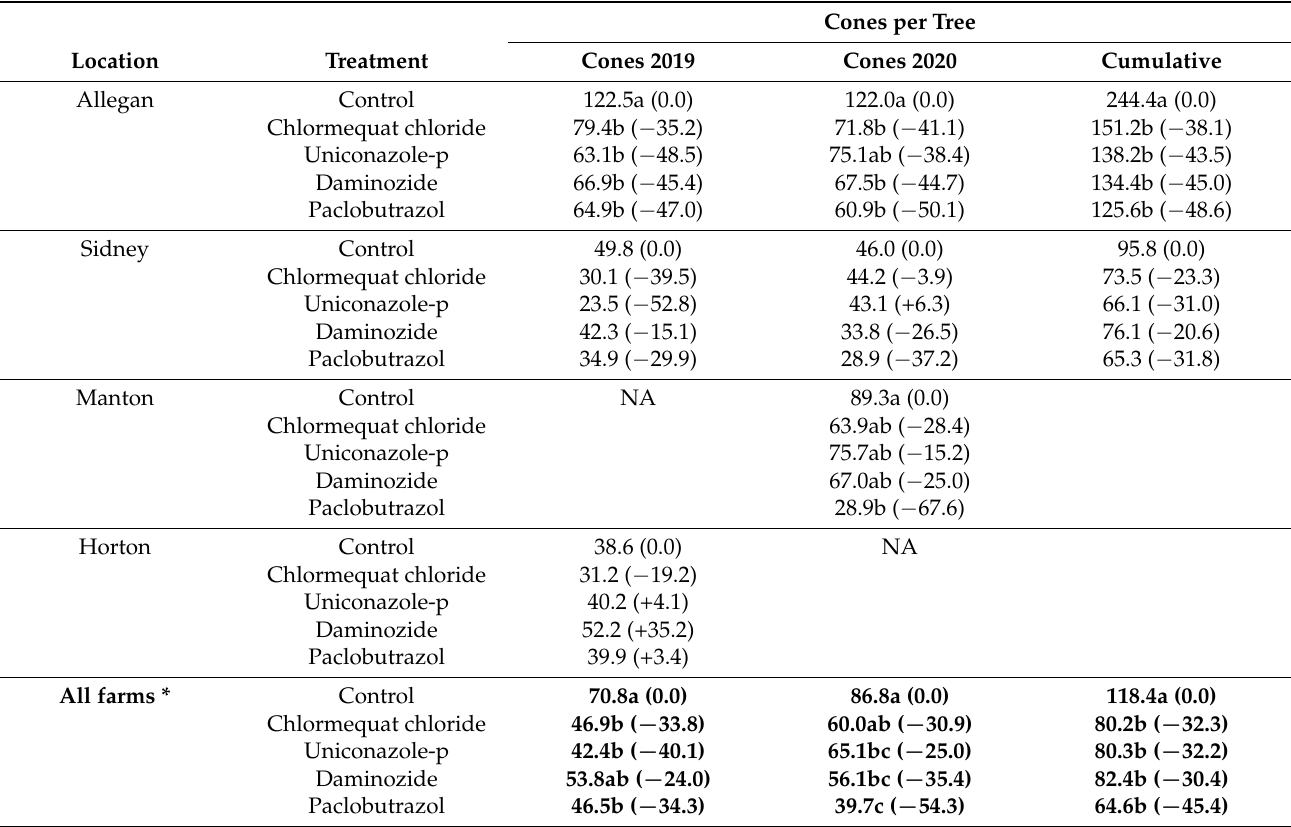
Table 3. Mean cone density (cones per tree) of Fraser fir trees treated with four foliar applied plant growth regulators or not treated (control). Treatments were applied annually 2018–2019. Figures in parentheses indicate change in means relative to untreated